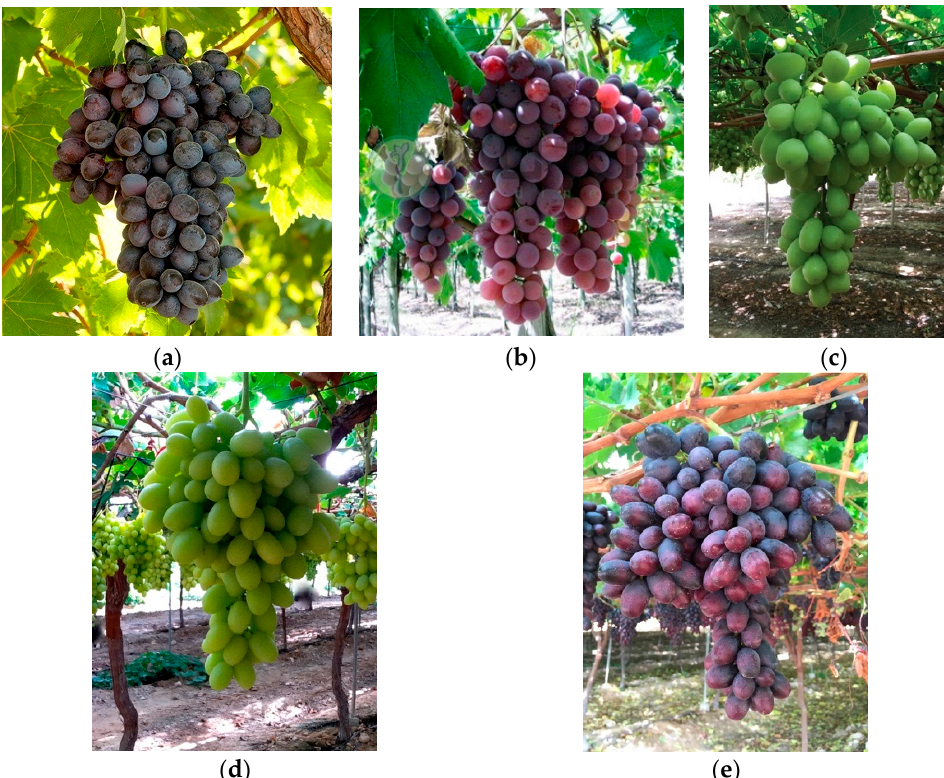
Figure 5. Varieties of grape grains used in the MIS acquisition process: ( a ) Autumn Royal, ( b ) Crimson Seedless, ( c ) Itum 4, ( d ) Itum 5 and ( e ) Itum 9.